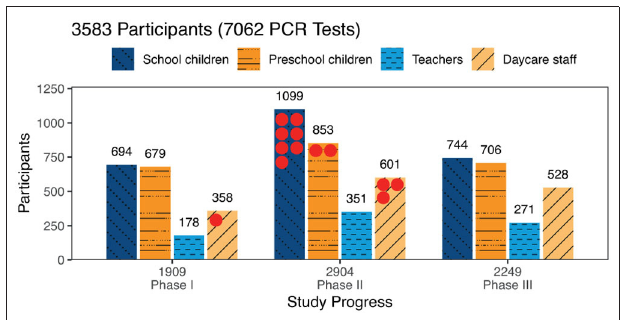
FIGURE 3 | Participants tested by phase and study group: Numbers of participants tested are given by study group and study phase.